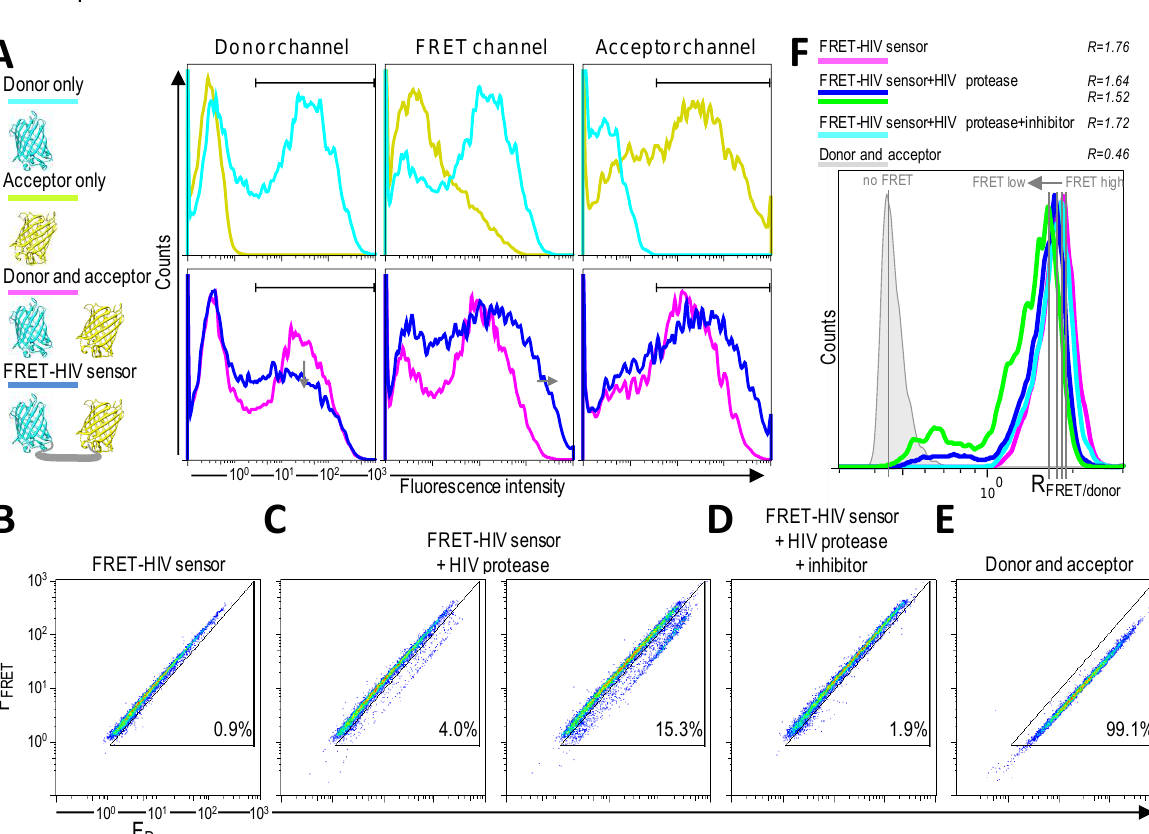
Figure 4. Ratiometric flow cytometry, in combination with the FRET-HIV sensor, was used for single-cell analysis of the HIV protease activity. ( A ) Pulse height emission signals of the donor, FRET, and acceptor of the HEK293T cells transfected with plasmids expressing the FRET-HIV sensor and controls after excitation with 405- and 488-nm lights. The arrows indicate the fluorescence intensity shifts forced by FRET. All profiles were gated from the region in the 2D plot of the forward- versus side-scatter (data not shown). The gated populations of cells (indicated by the straight line) represent cells that were further analyzed for FRET efficiency. 2D plots of the fluorescence intensities of the F versus the F of cells transfected with plasmids expressing ( B ) the FRET-HIV FRET donor sensor, ( C ) the FRET-HIV sensor with the HIV protease without or ( D ) with the protease inhibitor saquinavir (5 μM), and ( E ) the mCerulean and mCitrine expressed separately. Percentage of cells with reduced FRET is indicated. And ( F ) Histogram of the fluorescence intensity (F /F ) ratios. Note: The peak of the ratio distribution differed for different FRET donor type of cells. Depicted flow cytometry plots are representative results of three independent